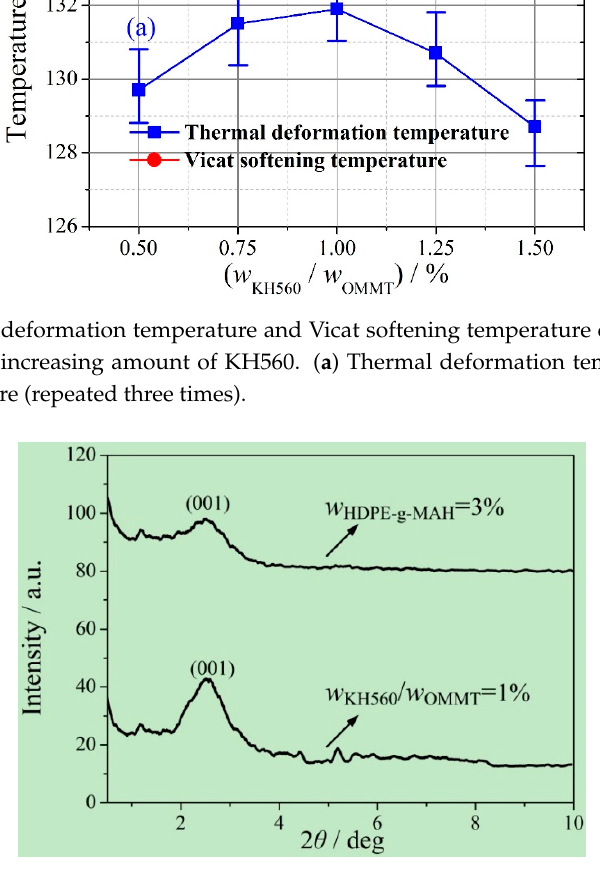
Figure 11. Comparison of small-angle XRD curves of OMMT-modified UHMWPE between using HDPE-g-MAH and using KH560.